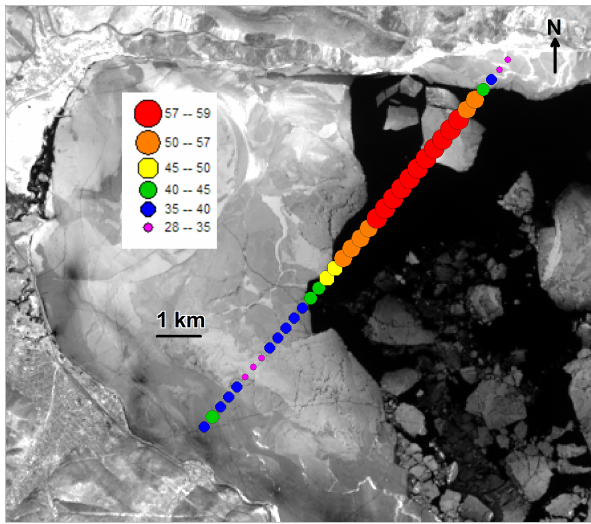
Figure 11. Backscatter values (dB) for the Jason-3 track 79, cy- cle 155 (26 April 2020, 20:00LT) overlaid over a Landsat 8 image for 26 April 2020, 11:57LT. Projection UTM 48N.